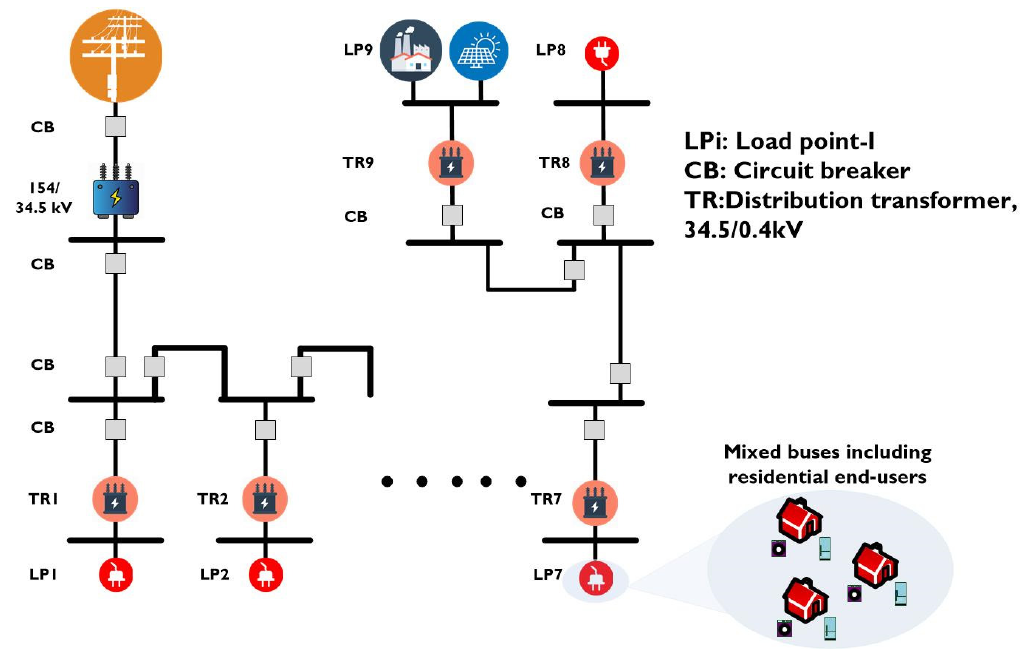
Figure 1. General overview of the distribution system model for the test cases.